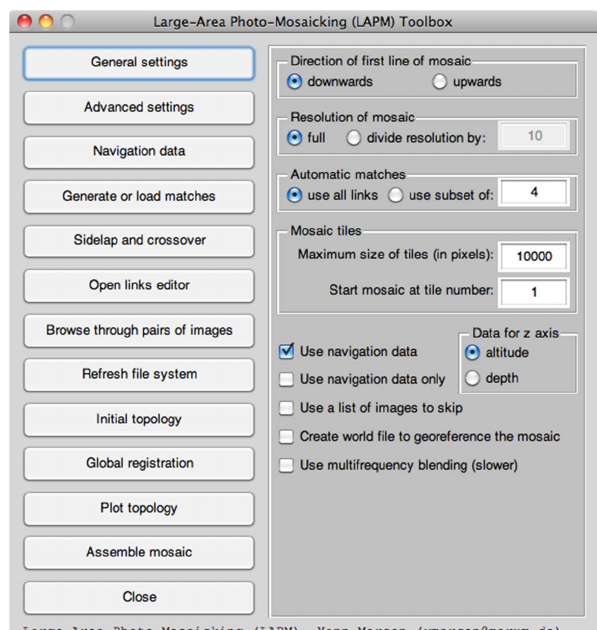
Fig. 2. Graphical user interface (GUI) of the large-area photo- mosaicking (LAPM) tool; the column of buttons is designed to guide the user through the mosaicking process. Several menus al- low the end user fully control the tool.